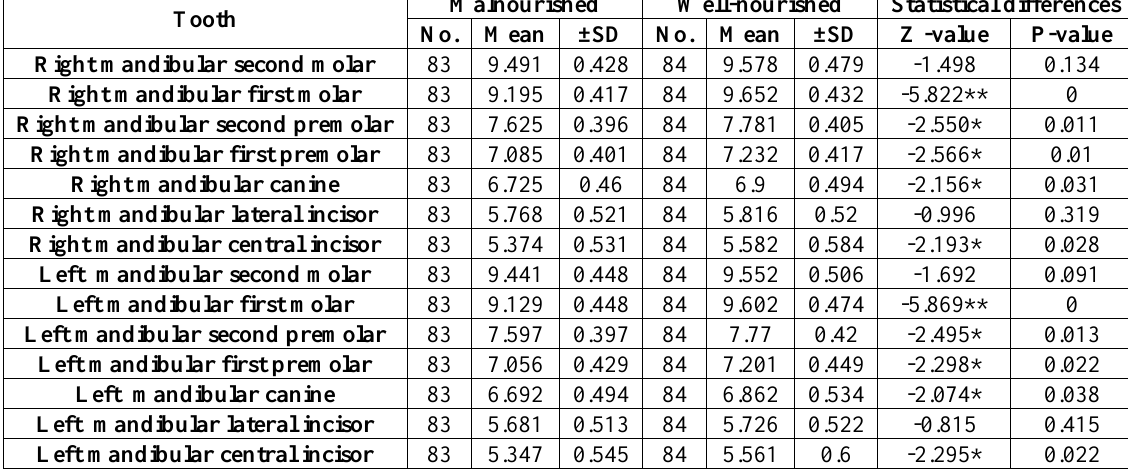
Table 3: Measurement of bucco-palatal diameters (mm) of maxillary teeth in malnourished and well-nourished group among adolescent aged 15 years by gender Malnourished Well-nourished Statistical differences Tooth No. Mean ±SD No. Mean ±SD Z -value P-value Right maxillary second molar 83 10.062 0.541 84 -10.717** 0 Right maxillary first molar 83 10.019 0 Right maxillary second premolar 83 8.347 -1.666 0.096 Right maxillary first premolar 83 8.327 0.312 84 0.315 -0.964 0.335 Right maxillary canine 83 7.179 0.442 -5.421** 0 Right maxillary lateral incisor 83 0.011 Right maxillary central incisor 83 0 Left maxillary second molar 83 -10.571** 0 Left maxillary first molar 83 Left maxillary second premolar 83 8.313 -1.802 0.072 Left maxillary first premolar 83 8.303 0.353 -0.611 0.541 Left maxillary canine 83 Left maxillary lateral incisor 83 0.013 Left maxillary central incisor 83 *P< 0.05, ** P<0.01 Table 4: Measurement of bucco-lingual diameters (mm) of mandibular teeth in malnourished and well-nourished group among adolescent aged 15 years by gender Malnourished Well-nourished Statistical differences Tooth No. Mean ±SD No. Mean ±SD Z -value P-value Right mandibular second molar 83 0.134 Right mandibular first molar 83 9.195 Right mandibular second premolar 83 0.011 Right mandibular first premolar 83 Right mandibular canine